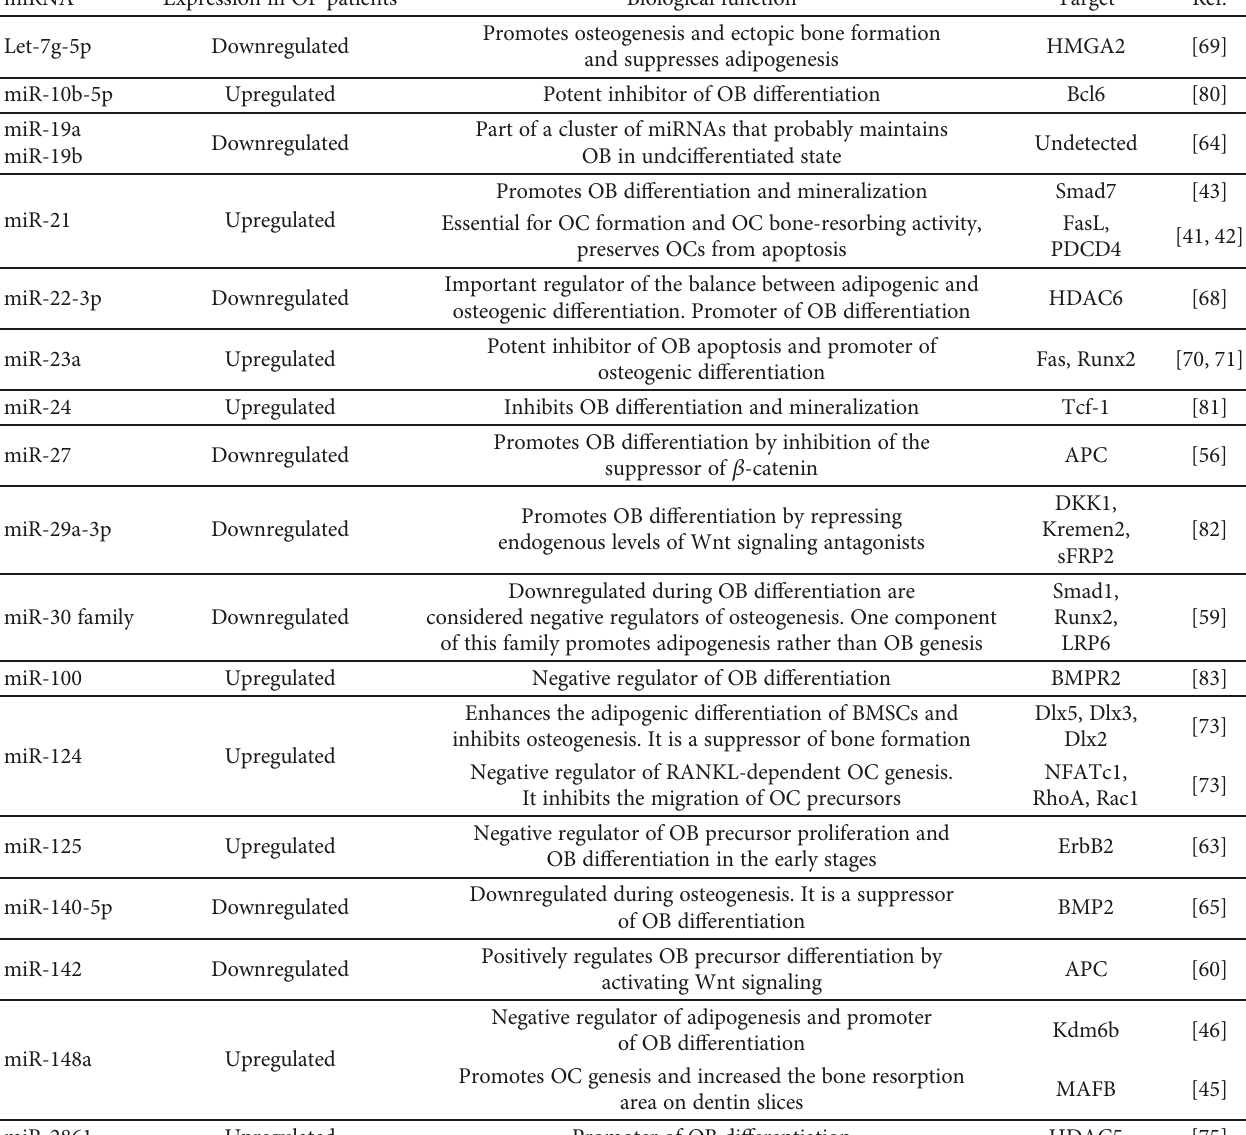
Table 2: miRNA dysregulated in serum of osteoporotic patients and their function.